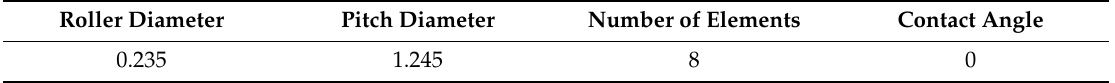
Table 2. The specific parameters of rolling bearing.